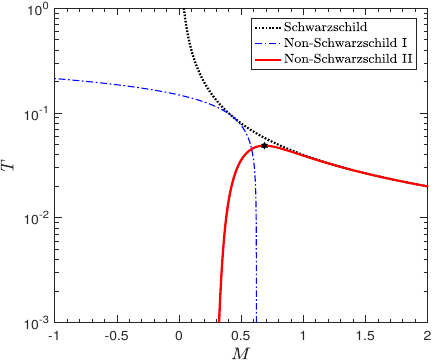
Figure 6 . Hawking temperature as functions of the ADM mass. Curves are marked in the same way as in figure